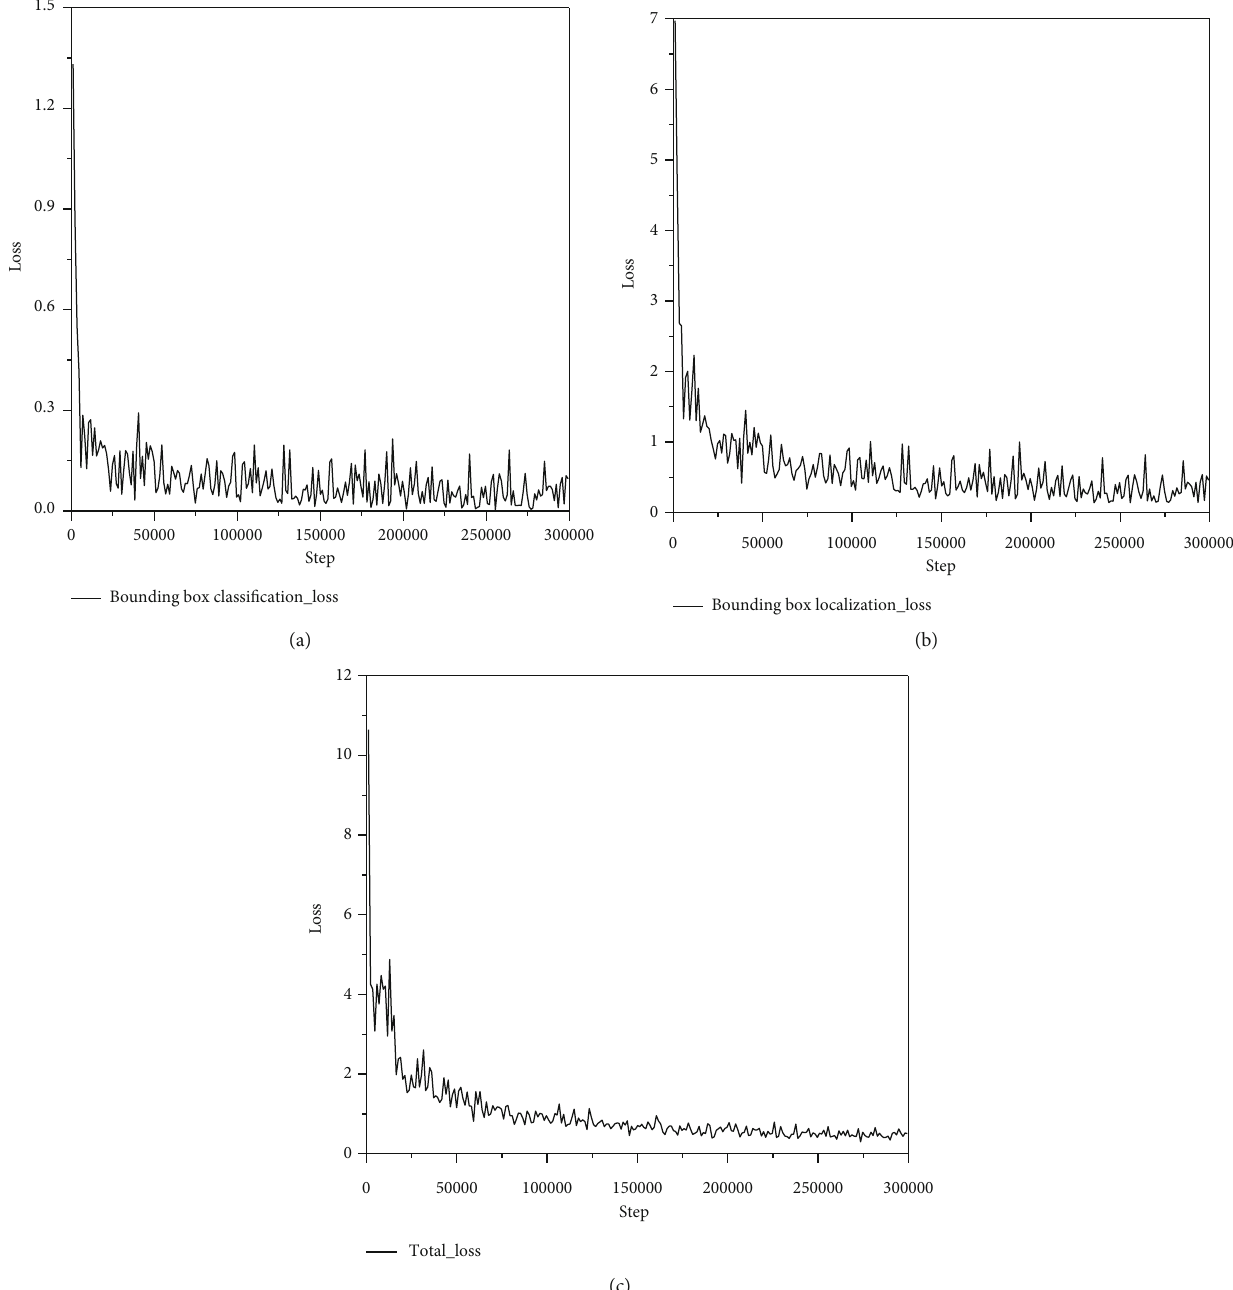
Figure 6: Loss functions: (a) classi fi cation loss, (b) localization loss, and (c) total